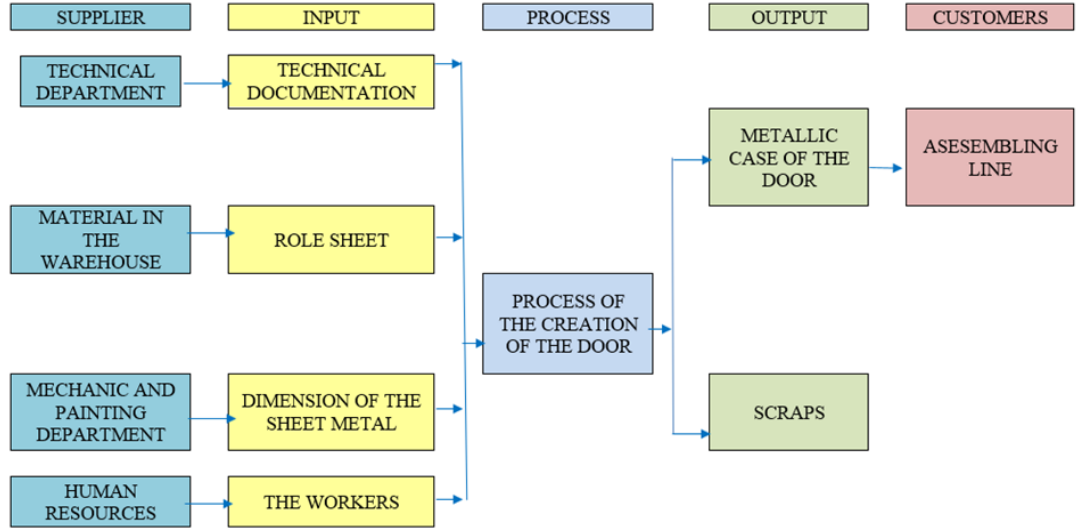
Figure 2. SIPOC Diagram.